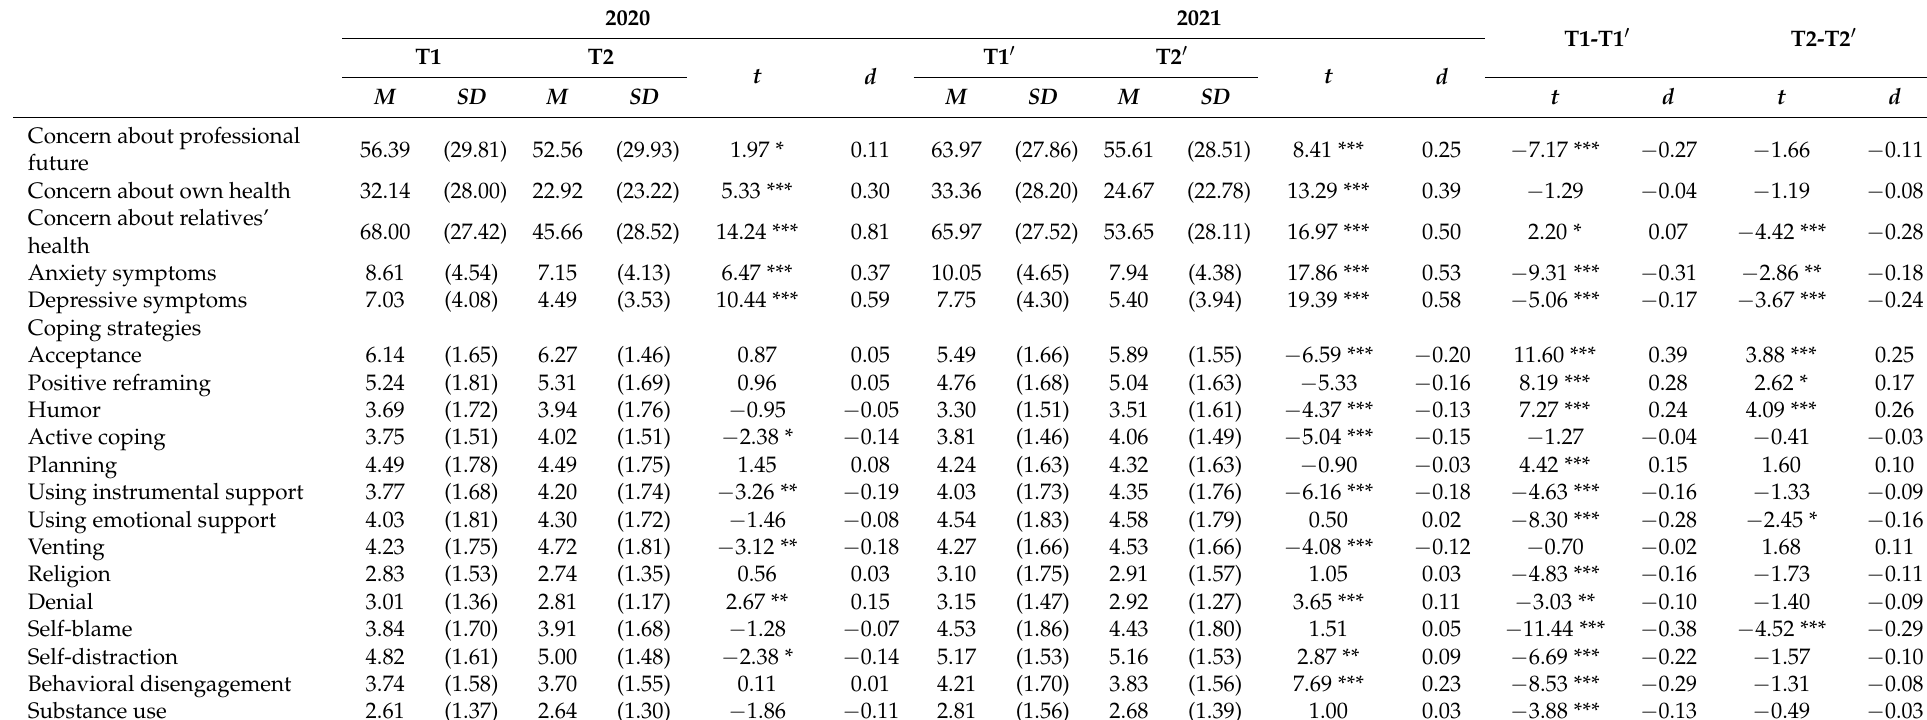
Table 2. Means (standard deviations) at four time points and mean